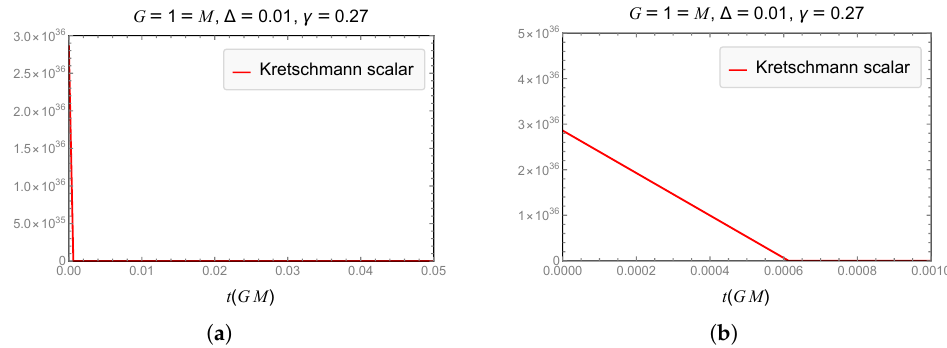
Figure 10. K in the ¯ µ case. ( a ) The Kretschmann scalar K for the ¯ µ case as a function of the Schwarzschild time t . ( b ) Close up of K close to t = 0. It is seen that K remains finite everywhere in the interior although it does not vanishes for t =